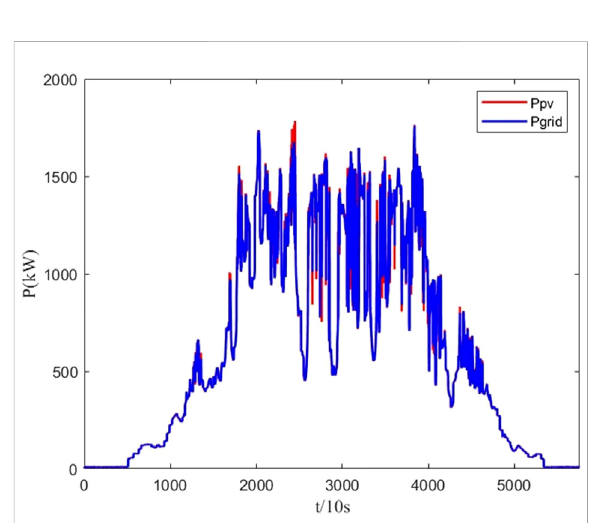
FIGURE 7 Comparison of grid-connected power calculated by low- pass fi ltering and original output.